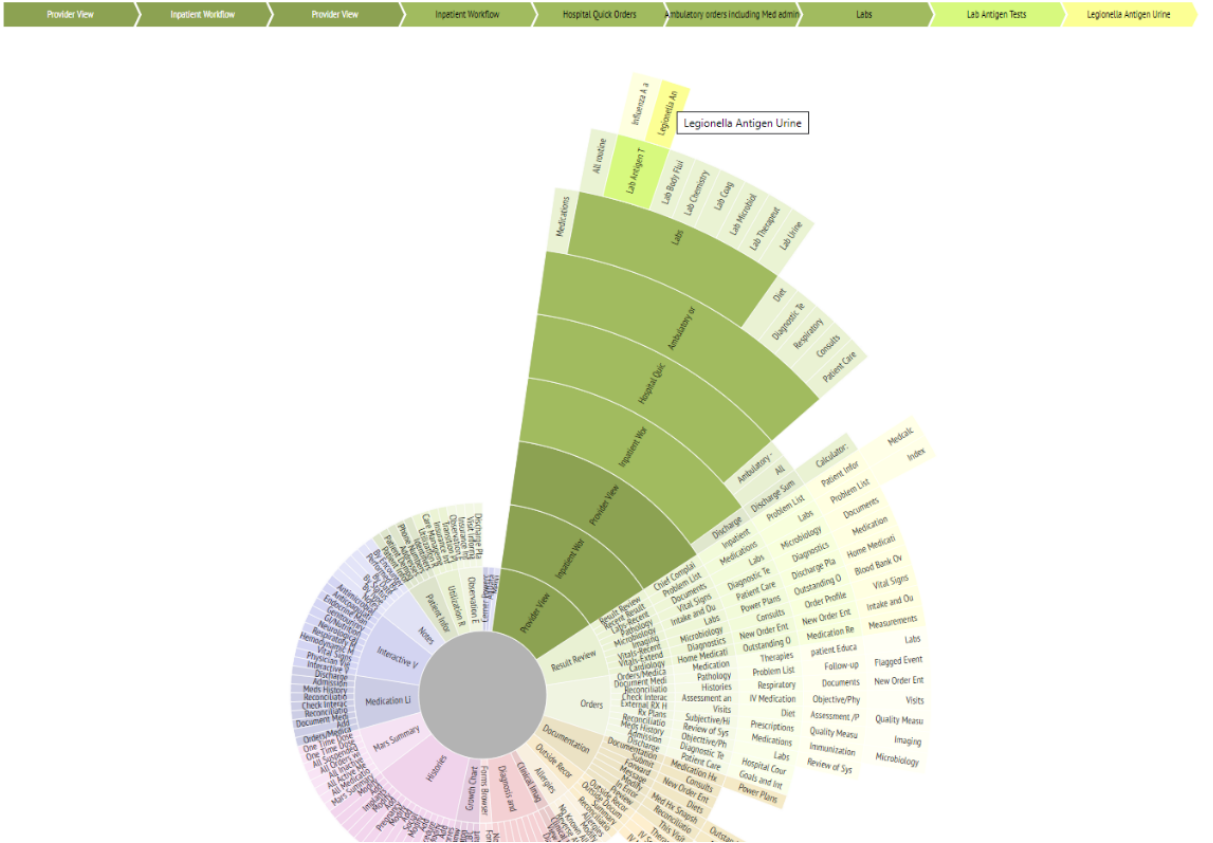
Figure 2. Interactive sunburst highlighting one pathway (in green) from a root screen (Provider View) to a specific element (Legionella Antigen Urine lab results). The traced pathway is also described in the linear flow above the sunburst diagram. This diagram shows how 9 different screens must be navigated to access the desired element from the main